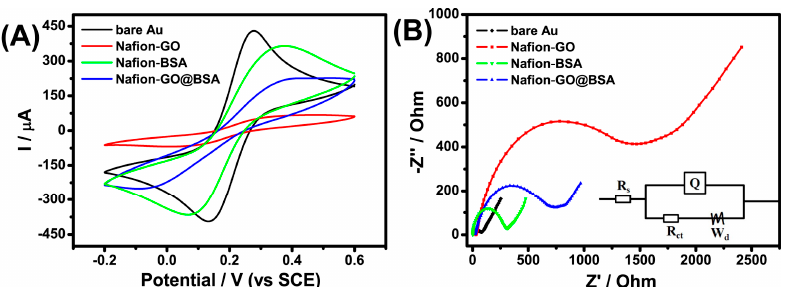
Figure 4. Cyclic voltammogram (CV) ( A ) and Nyquist plots ( B ) in the electrolyte containing 5 mM [Fe(CN) 6 ] 4-/3- and 0.1 M KCl. Scan rate of CV, 20 mV·s − 1 ; frequency range of Nyquist plots, 10 5 to 10 − 2 Hz. B inset: Equivalent circuit.